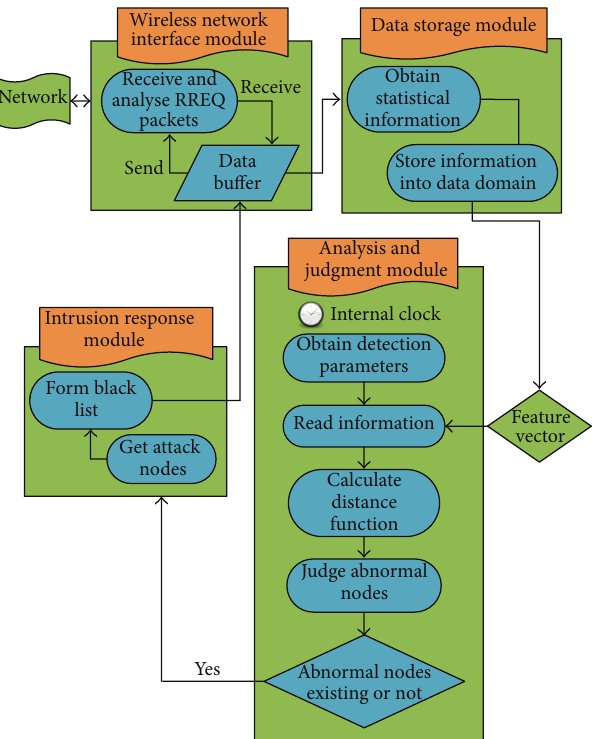
Figure 6: The schematic diagram of KNN intrusion detection